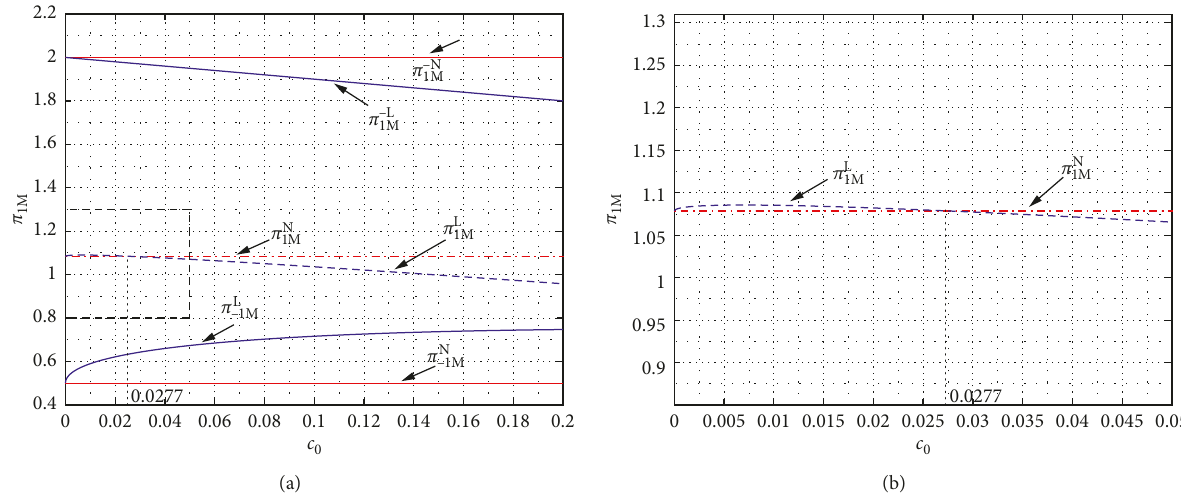
Figure 9: Relationship between c